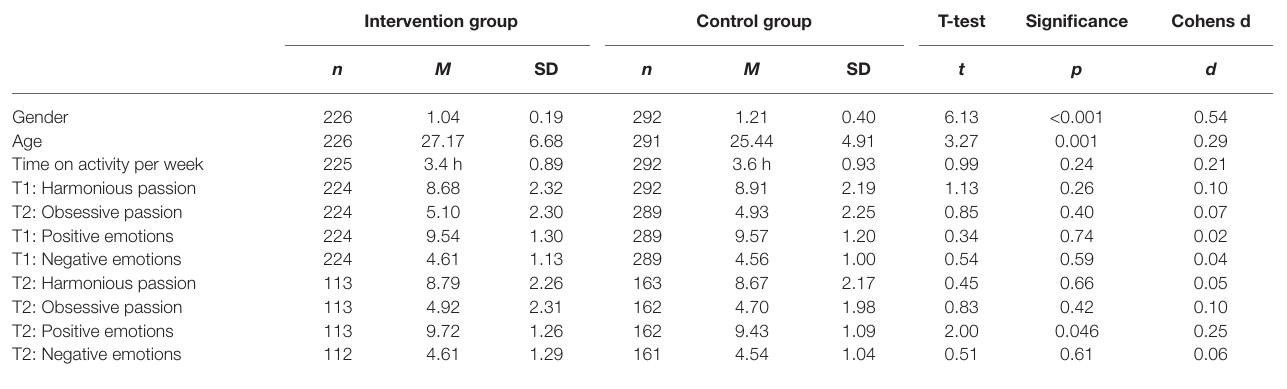
TABLE 1 | Descriptive statistic and t-tests for variables based on groups. Intervention